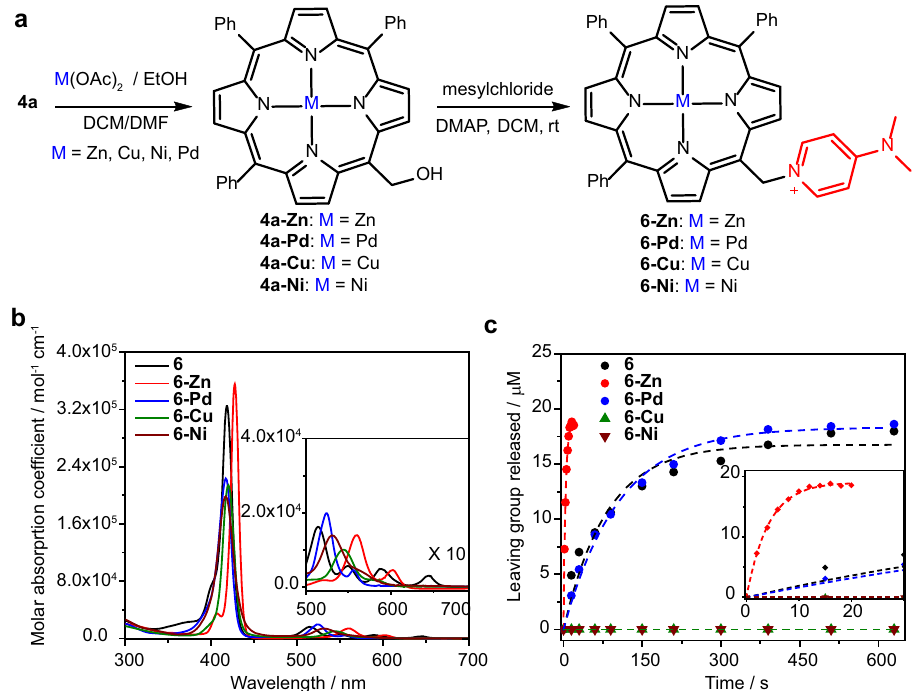
Fig. 4 Metal-containing meso -methylporphyrin PPGs: synthesis and photochemistry. a Synthesis of metal-containing meso -methylporphyrins followed by the installation of DMAP as a model leaving group. b Absorption spectra of DMAP-caged metal-containing meso -methylporphyrin derivatives (3 µ M, aerated DMSO); that of an analogous metal-free meso -methylporphyrin ( 6 ) is shown for comparison. Inlet: a 10-fold magni fi cation of the Q-bands region. c Photorelease of DMAP from metal-containing meso -methylporphyrin derivatives (25 µ M, degassed DMSO, λ irr = 410 nm, 40 mW cm − 2 ; HPLC-MS analysis), the reaction of an analogous metal-free meso -methylporphyrin ( 6 ) is shown for comparison. Inlet: focus on early time points.